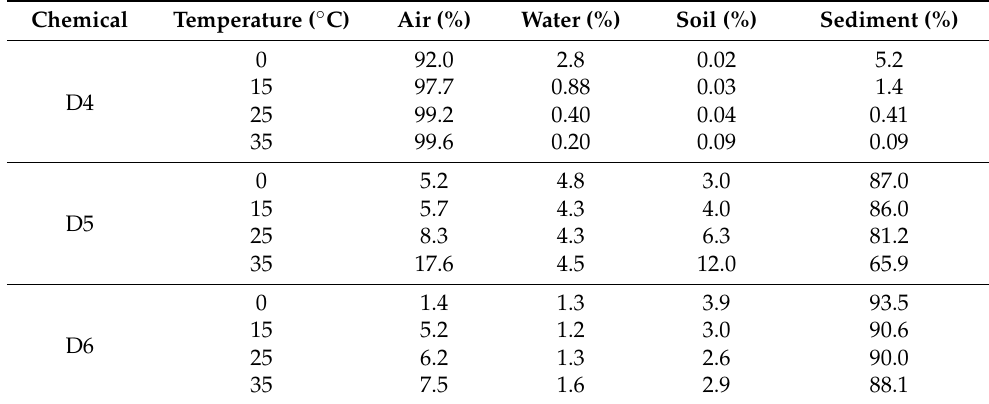
Table 4. Predicted fractions of the total mass of CMSs (D4–D6) from modelling the four different environmental media of